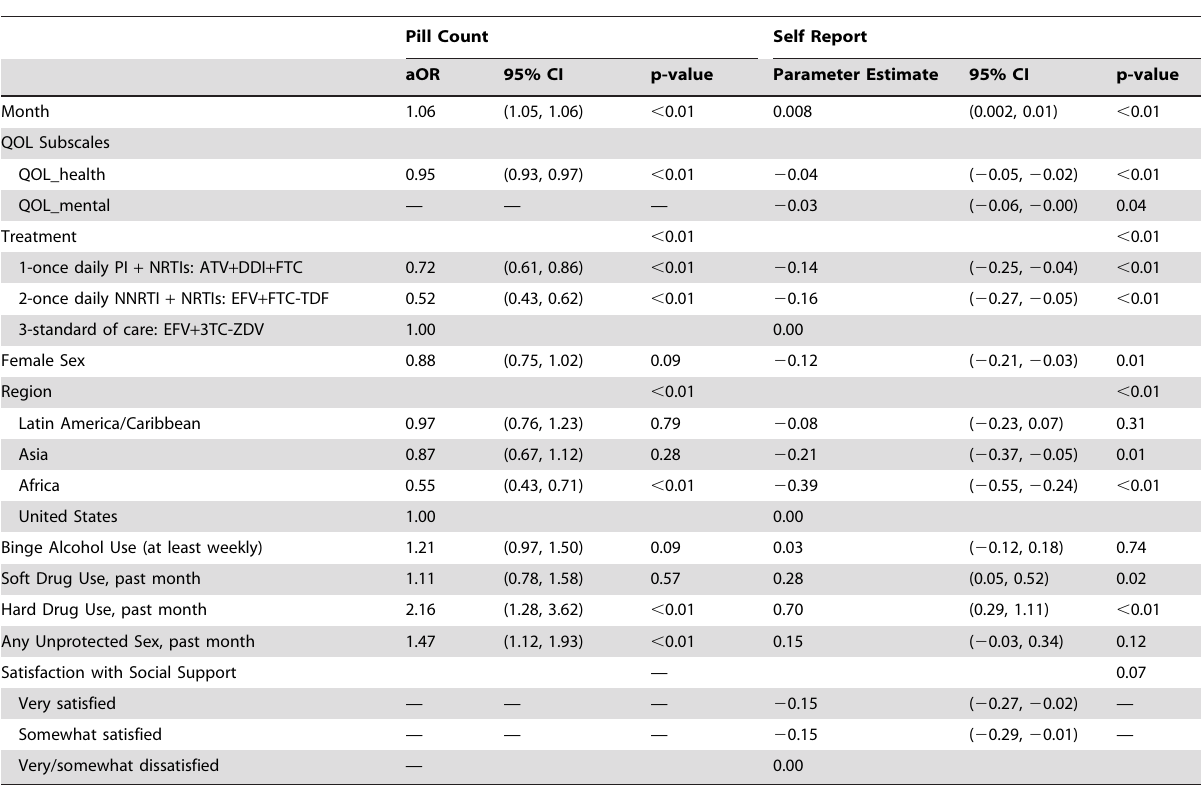
Table 3. Longitudinal Multivariable Predictors of Non-Adherence 1